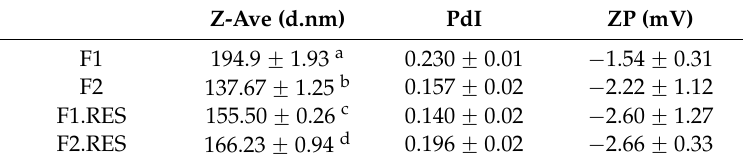
Table 2. Mean hydrodynamic diameter, polydispersity index and zeta potential of the SLNs ( n = 3). Z-Ave (d.nm) Z-Ave (d.nm)